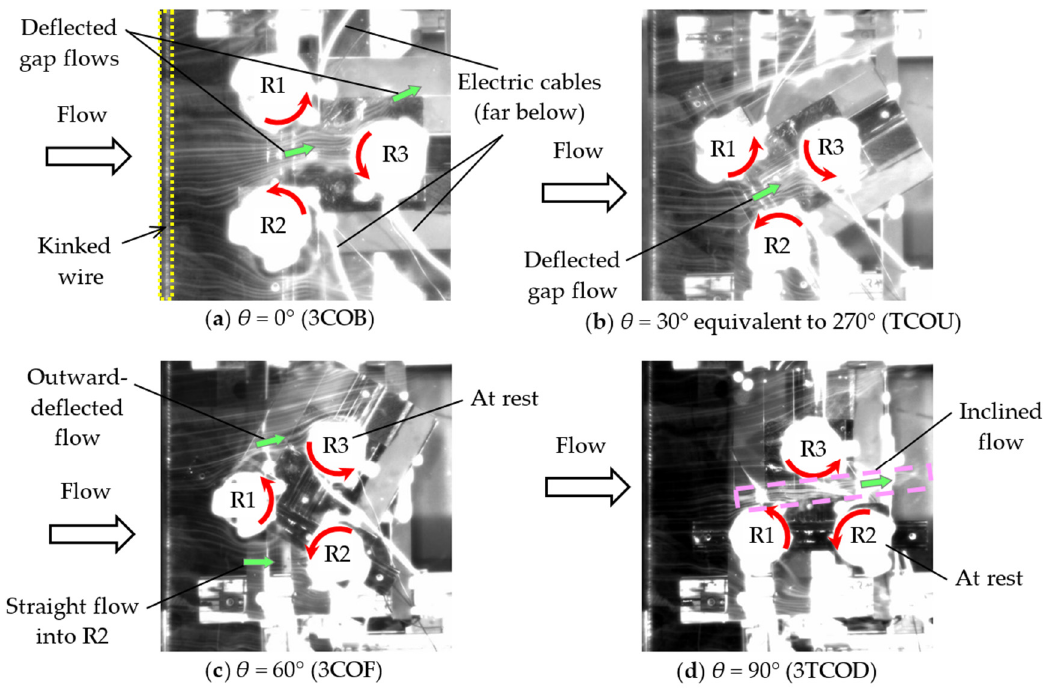
Figure 22. Photographs of smoke flow through three turbines at g / D = 1 under V = 2 m/s in the 3CO configuration: ( a ) θ = 0°; ( b ) θ = 30°; ( c ) θ = 60°; ( d ) θ = 90°.